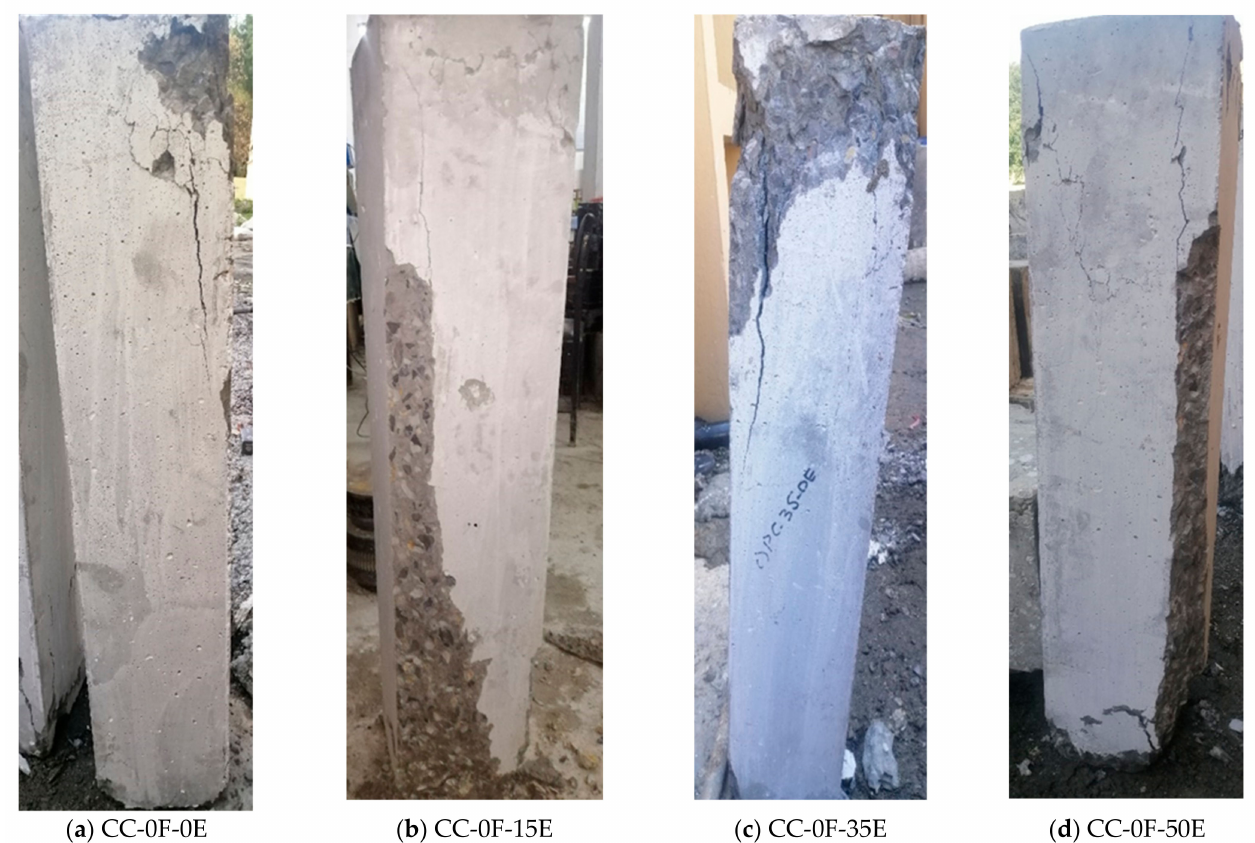
Figure 6. The failure mode of conventional concrete (CC) columns after the